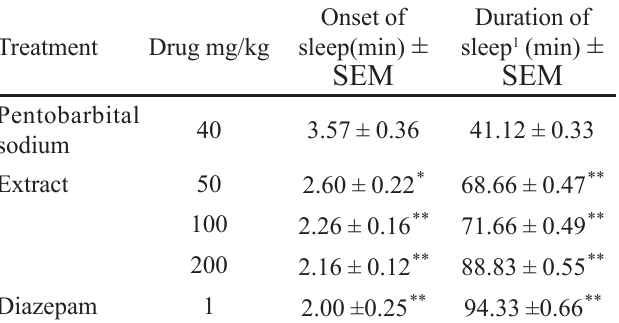
TABLE III - Effect of PO extract on sodium pentobarbital-induced sleeping time in mice